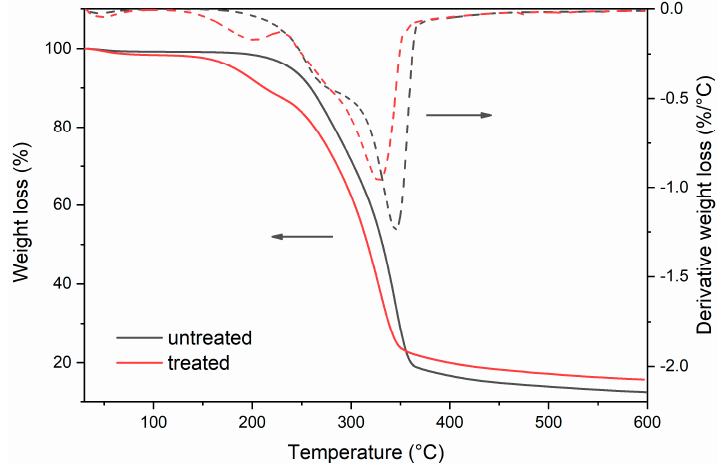
Figure 9. Thermogravimetric (TG) and differential thermogravimetric (dTG) curves of untreated and treated wood samples. The treated wood sample had higher weight residue than untreated wood.